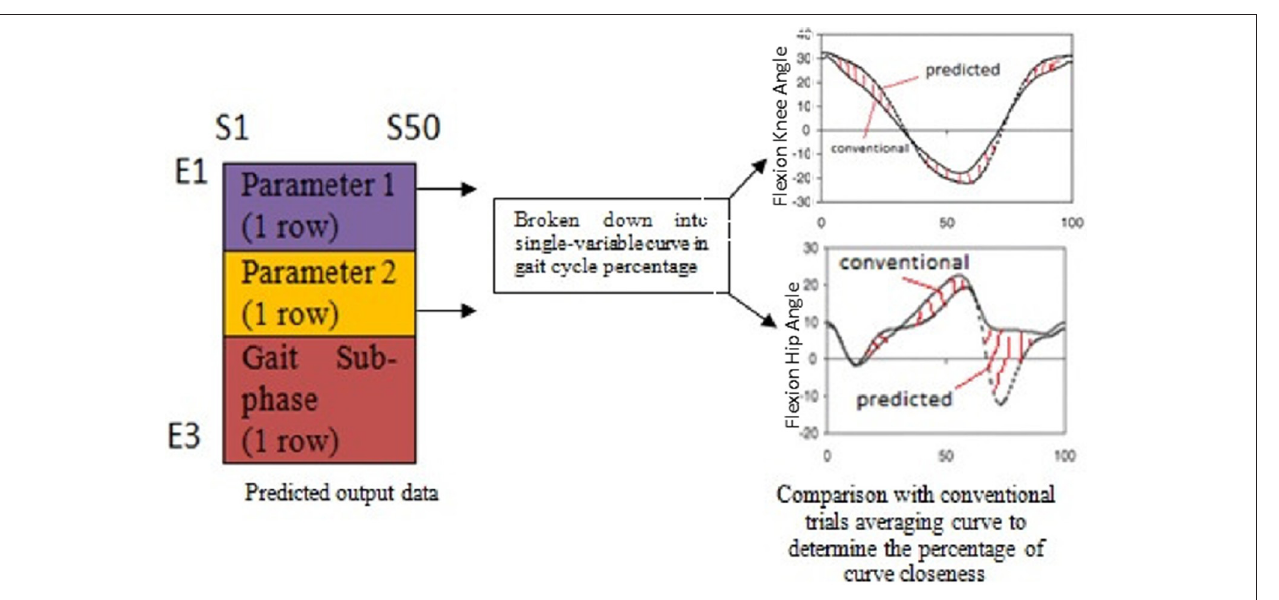
FIGURE 3 | Workflow to validate the network prediction ability; the errors between the two curves were calculated at each point for each case of the